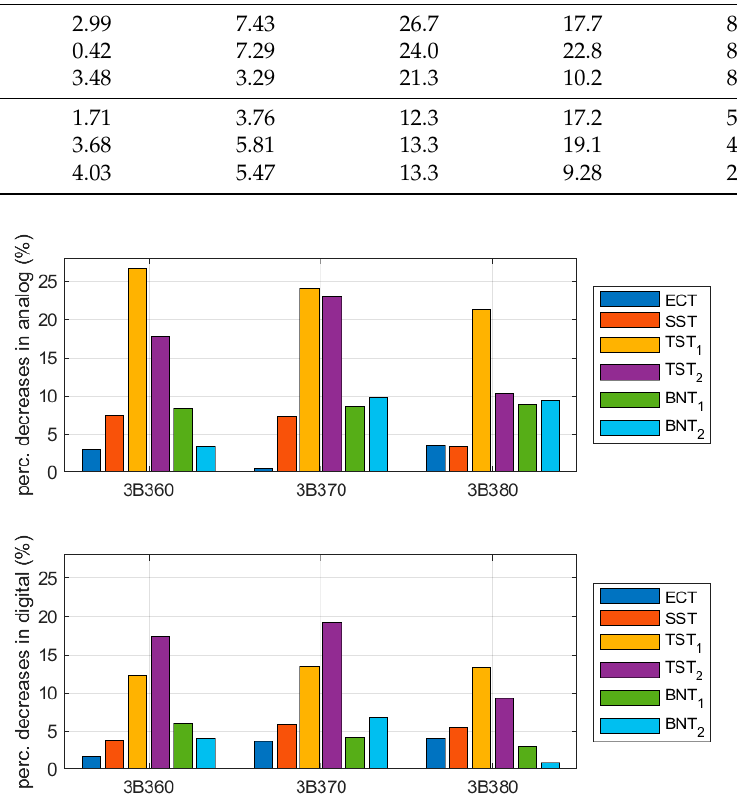
Figure 9. Bar plots of percentage differences between results for crease-free region samples and samples with a crease along the sample length.